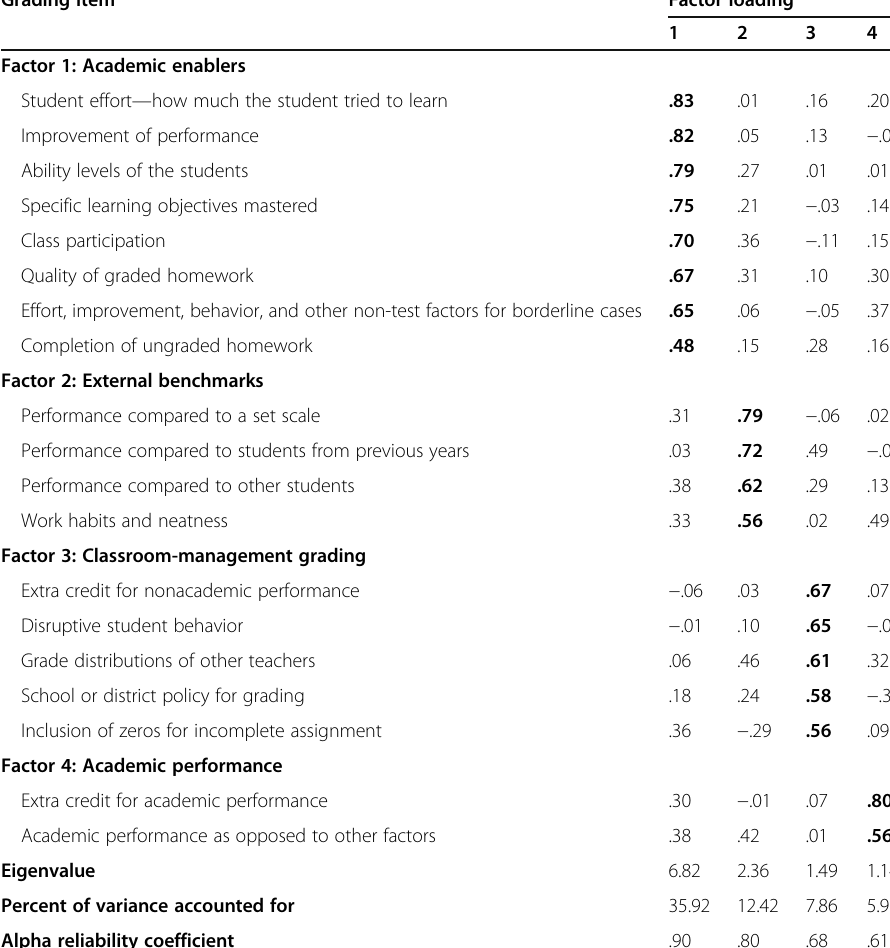
Table 4 PCA outputs for private EFL institute teachers ’